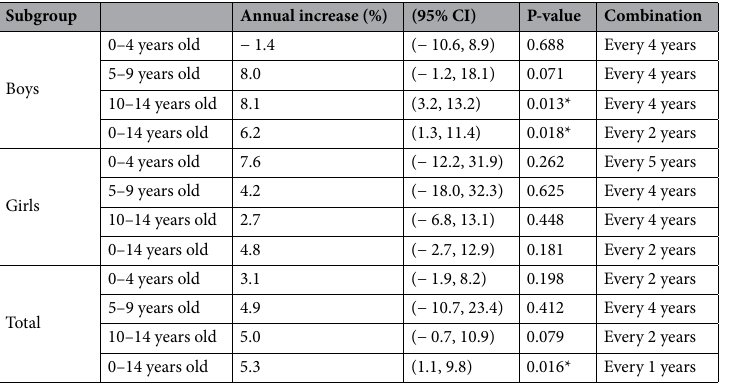
Table 2. Annual increases in incidence rate for 20-year period (1999–2018) as estimated by mixed effects Poisson regression in subgroups defined by age group and sex. The cohort is not processed if some of the records for a cohort have zero counts. We aggregated the data by combining some of the years in order to eliminate the zero values according to the software operation manual. We combined the data in the smallest units. *P <